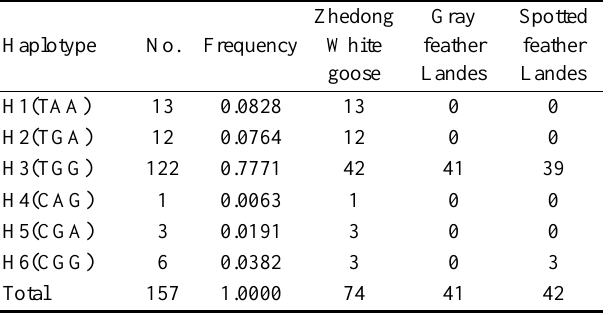
Table 5. Distribution of diplotypes in different goose